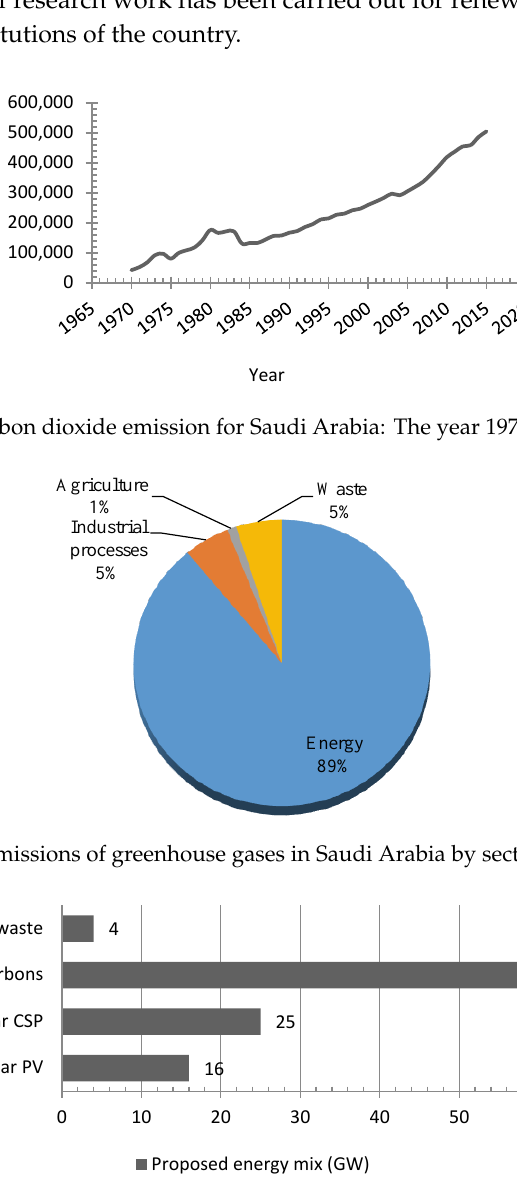
Figure 1. Carbon dioxide emission for Saudi Arabia: The year 1970–2016 [2].